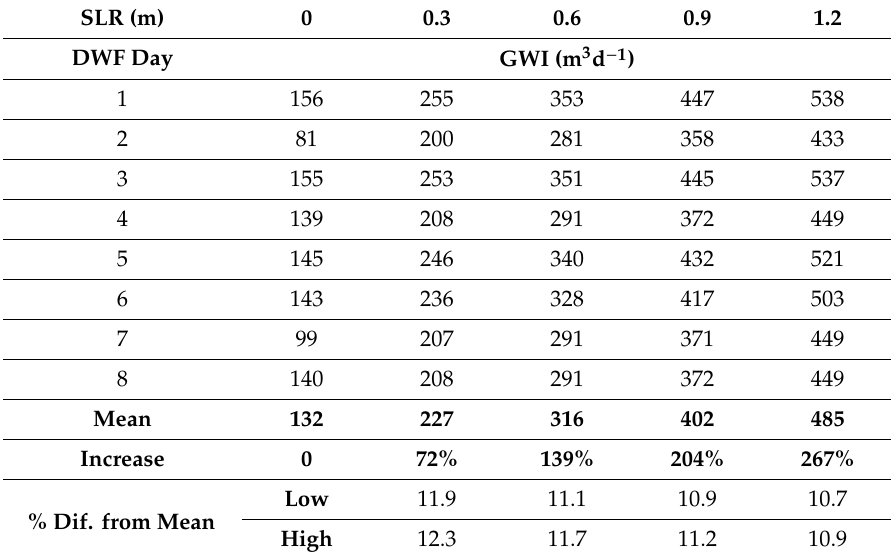
Table 3. Projected GWI due to future SLR in currently submerged